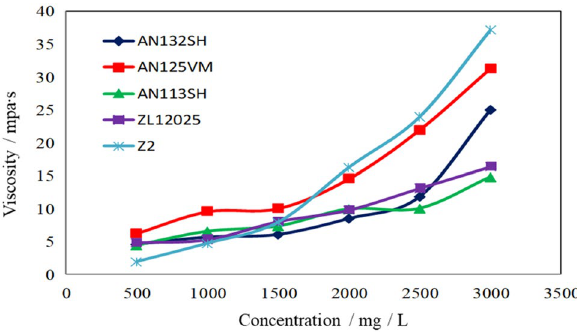
Fig. 3 Viscosifying effect of different polymers